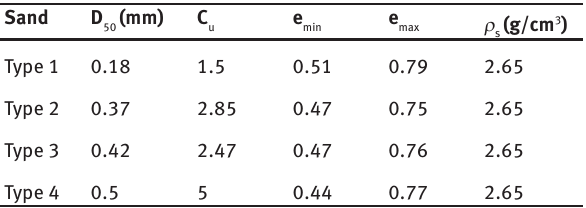
Table 3: Characteristics of the materials to be analyzed.